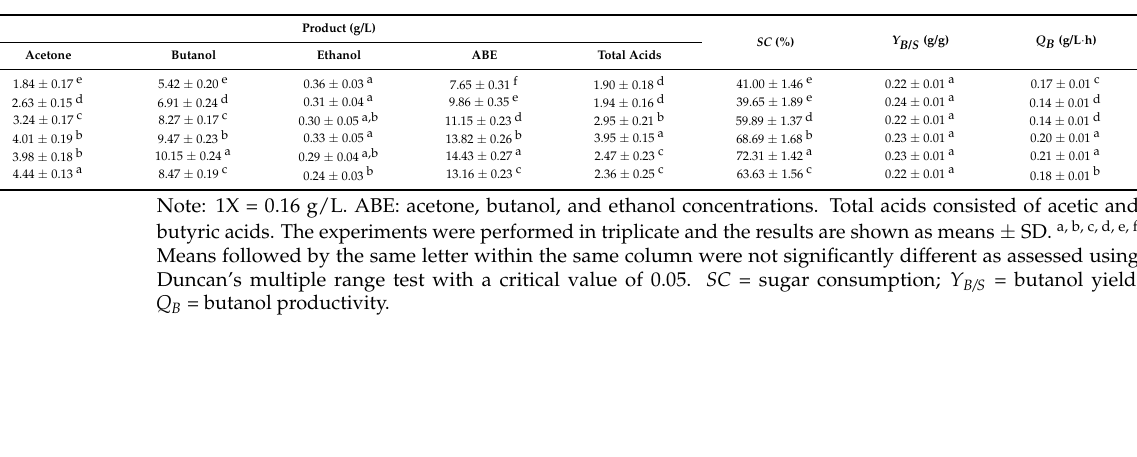
Table 5. Batch butanol fermentation efficiency levels from SSJ medium supplemented with urea at various concentrations at 48 h of